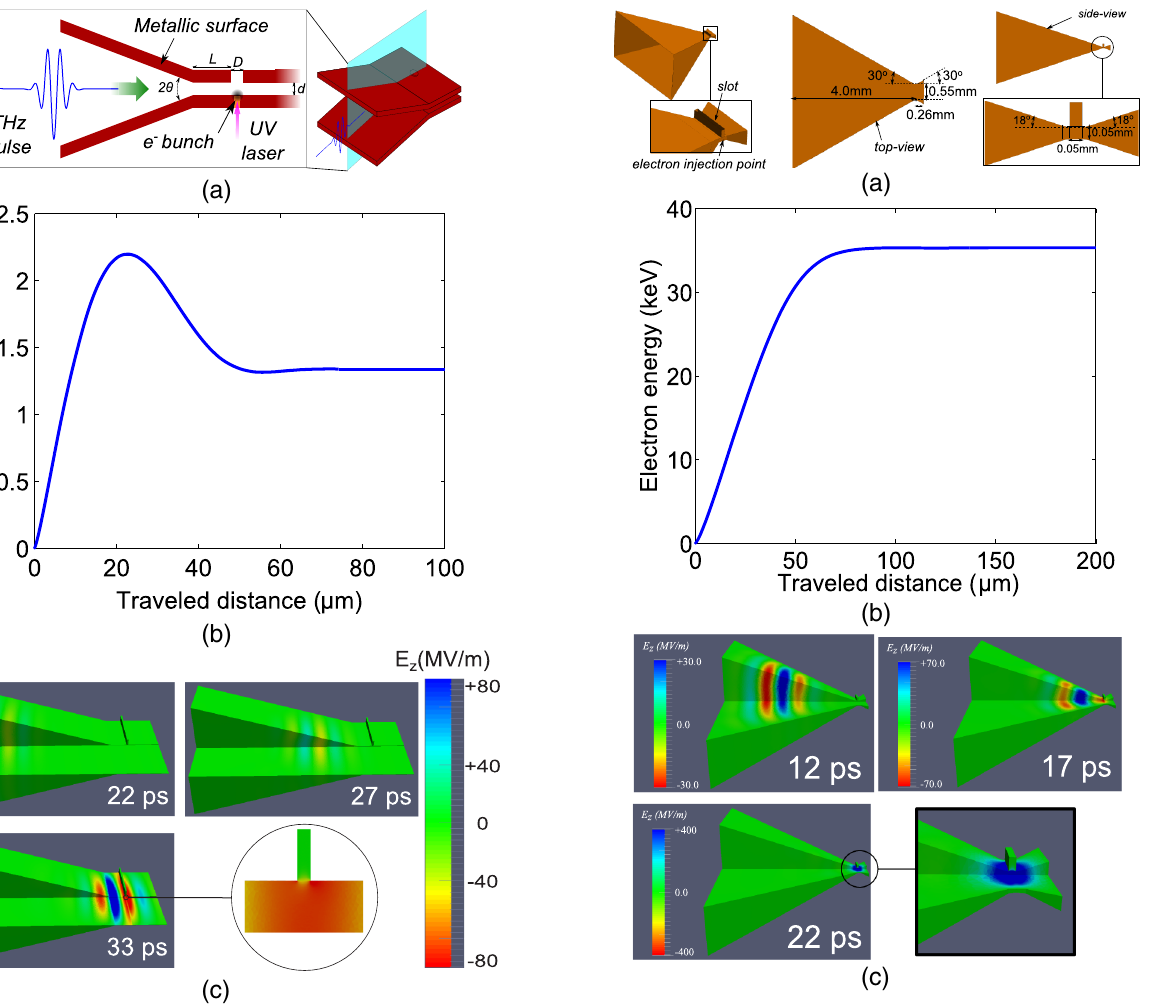
) profile over two half- z